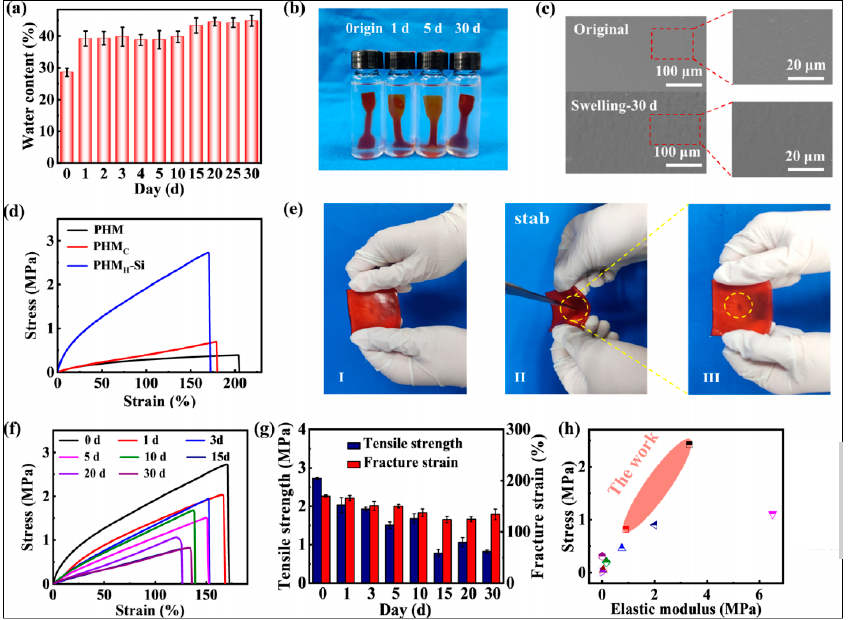
Figure 3. Swelling resistance and mechanical stability of the estradiol-loaded mesoporous silica- poly (hydroxyethyl methacrylate) (PHEMA) hydrogel (PHMH-Si). ( a ) The swelling rate of the PHMH-Si hydrogel in simulated uterine fluid for 30 days. ( b ) The actual pictures of the PHMH-Si hydrogel immersed in the simulated uterine cavity fluid for 0, 1, 5, and 30 days. ( c ) SEM of the PHMH-Si hydrogel before and after swelling in the simulated uterine fluid for 30 days. ( d ) Tensile stress–strain curves of the hydroxyl methacrylate/maleic anhydride (PHM), PHM/N, N-methylenebisacrylamide (PHMC), and PHMH-Si hydrogels. ( e ) Macroscopic photographs demonstrating the puncture resistance of the PHMH-Si hydrogel via scissors. ( f ) Stress–strain curves and ( g ) elastic moduli–fracture toughness histogram of the PHMH-Si hydrogel soaked in simulated uterine fluid for 30 days. ( h ) Mechanical properties of the PHMH-Si hydrogel in the